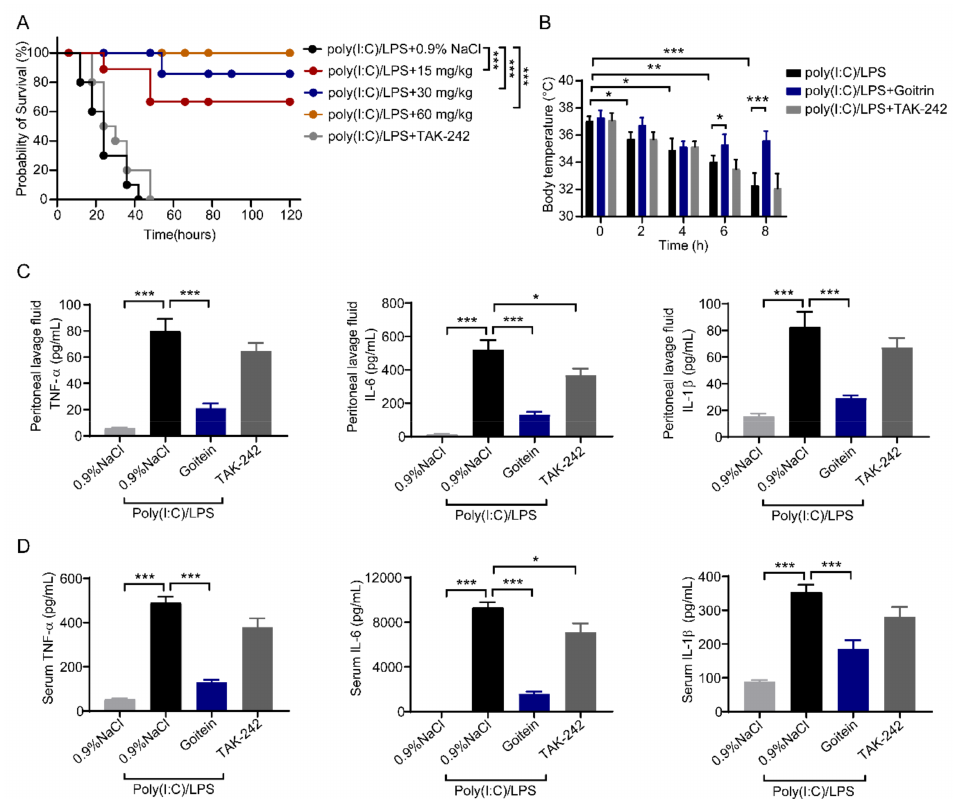
Figure 8. Goitrin attenuates caspase-11-mediated lethal septic shock. ( A ) Kaplan–Meier survival analysis and body temperature were monitored. Mice were primed with poly(I:C) [4 mg/kg, ip (intraperitoneally)] and challenged 6 h (h) later with LPS (20 mg/kg, ip) in the absence or presence of goitrin (15, 30, or 60 mg/kg) or TAK-242 (3 mg/kg) ( n = 10, *** p < 0.001, Kaplan–Meier survival analysis). ( B ) Body temperature of mice was monitored by measuring the temperature of the rectum and recorded for 8 h ( n = 6). ( C , D ) Quantitation of IL-6, IL-1 β , and TNF- α levels in peritoneal lavage fluid and serum. Mice were primed with poly(I:C) [4 mg/kg, ip (intraperitoneally)] and challenged 6 h (h) later with LPS (20 mg/kg, ip) in the absence or presence of goitrin (30 mg/kg) or TAK-242 (3 mg/kg), the mice were sacrificed 8 h later ( n = 6). * p < 0.05, ** p < 0.01, *** p < 0.001 (ANOVA LSD